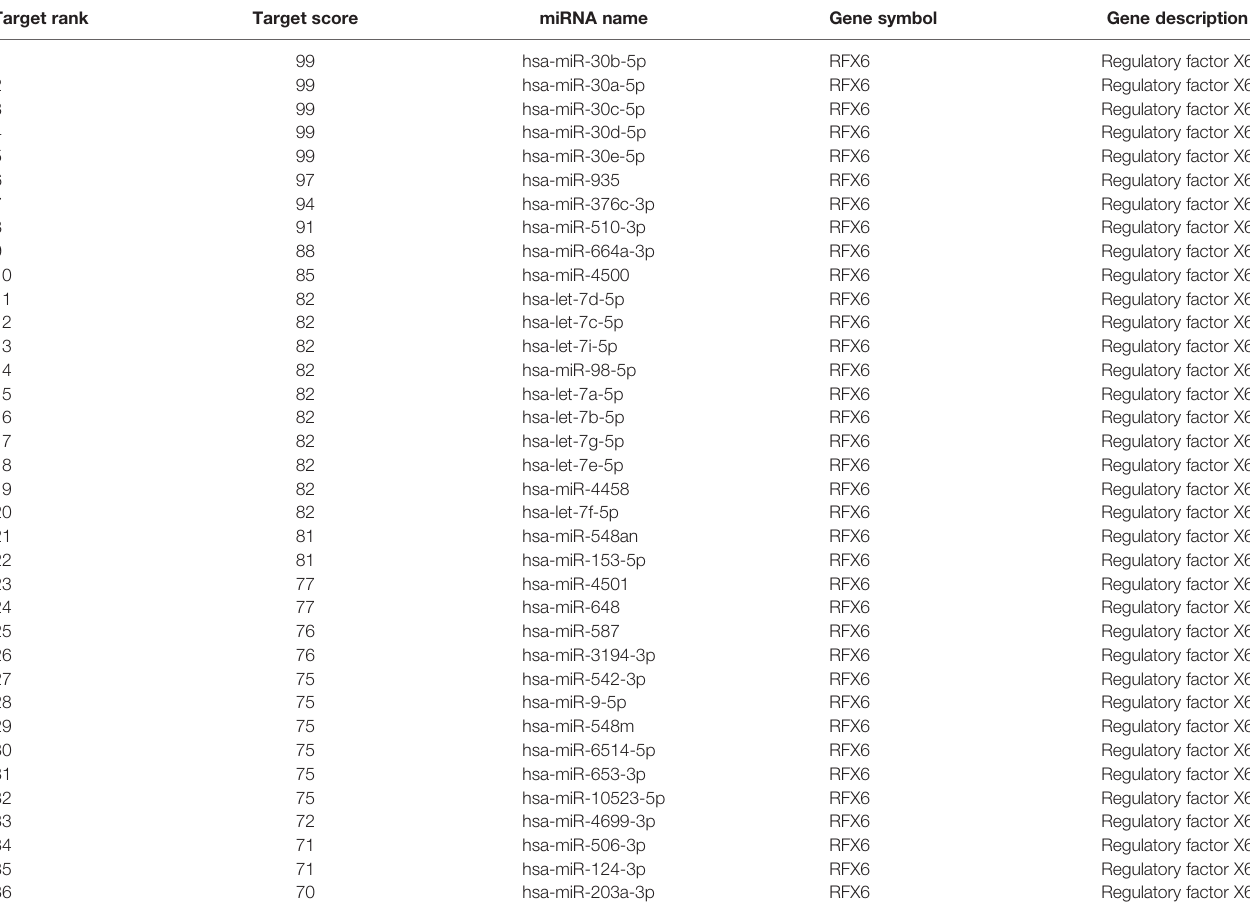
TABLE 2 | miRNA prediction results of RFX6